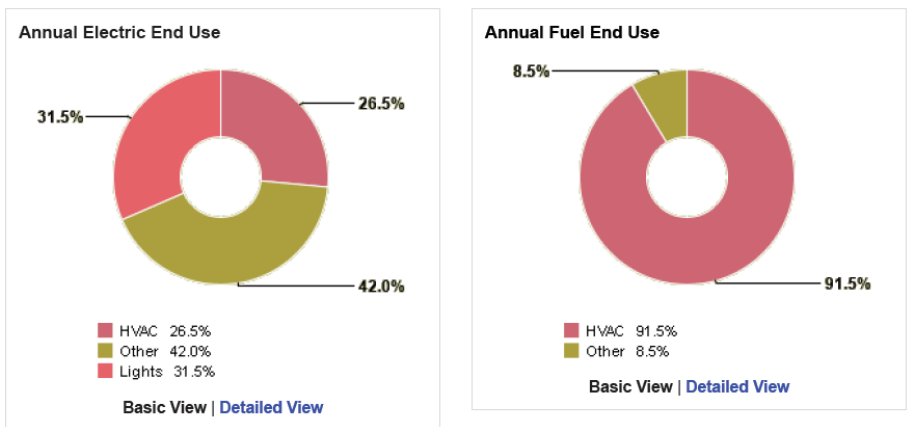
Figure 23 . Annual costs of Single skin facade (Green Building Studio). Figure 23. Annual costs of Single skin facade (Green Building